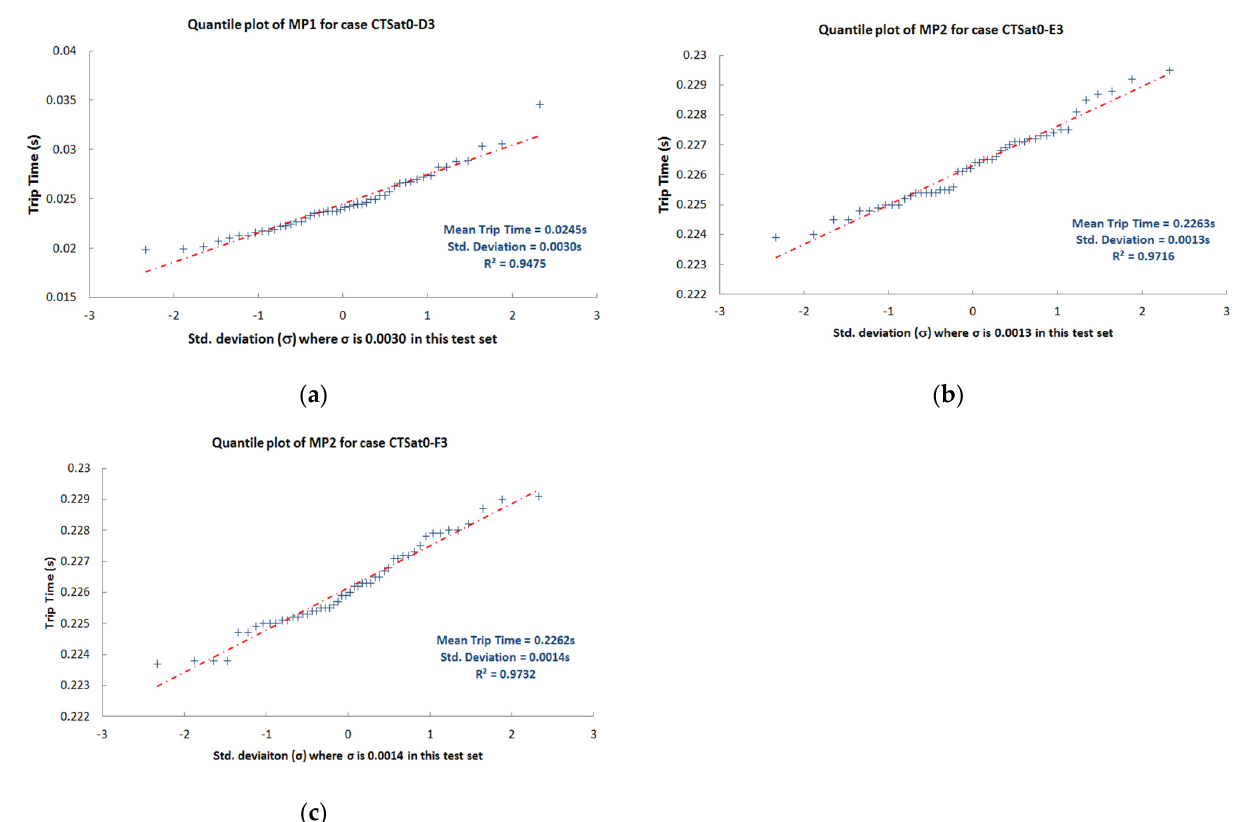
Figure 30. Quantile plot for cases: ( a ) CTSat0-D3 (ideal CT, no faulty device, L-L-G fault at 100% of the feeder); ( b ) CTSat0-E3 (ideal CT, 1 faulty AMU, L-L-G fault at 100% of the feeder); and ( c )